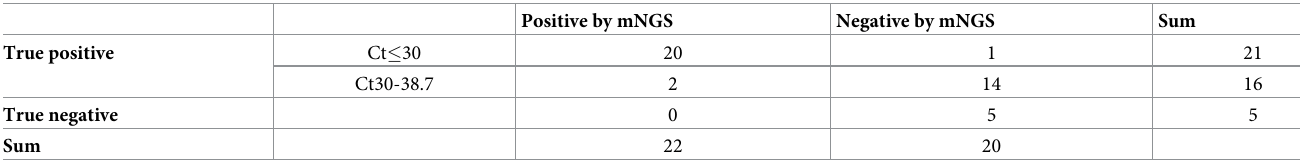
Table 3. Overall sample classification, after adjustment for barcode